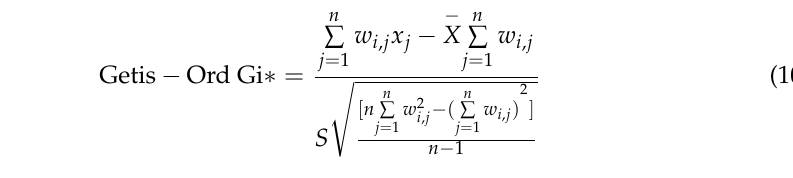
Table 3. Criteria for determining the spatiotemporal state of rock mass fractures due to mining.